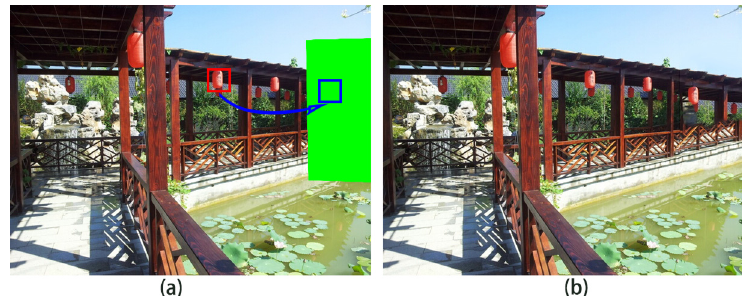
Fig 3. No transformation for image completion: (a) no transformational source patch, (b) results of the Barnes method [12].